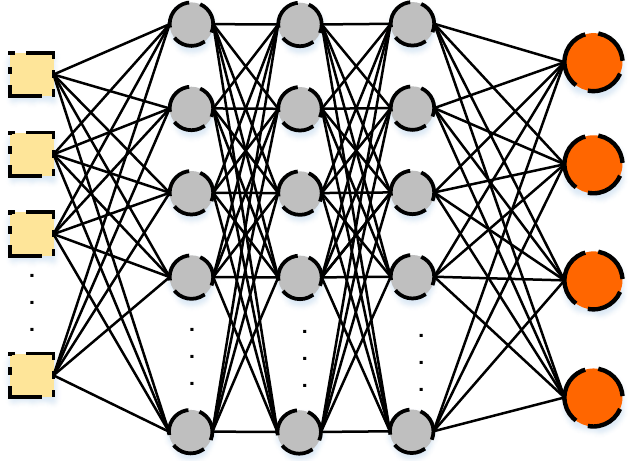
Figure 2. Sequential Model of a Deep Neural